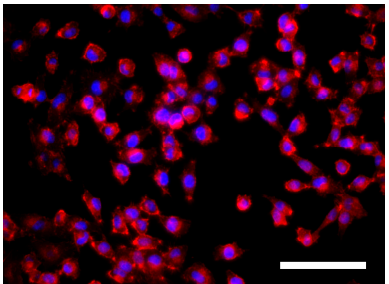
Figure 2. MDA–MB–231 cells grown in two-dimensional (2D) adherent coverslips. Actin cytoskeleton was stained with rhodamine-phalloidin (red) and nucleus was stained with 4,6-diamidino-2-phenylindole (DAPI; blue). Fluorescence microscopy images were captured at a magnification of 200× (Scale bar: 100 μ m).